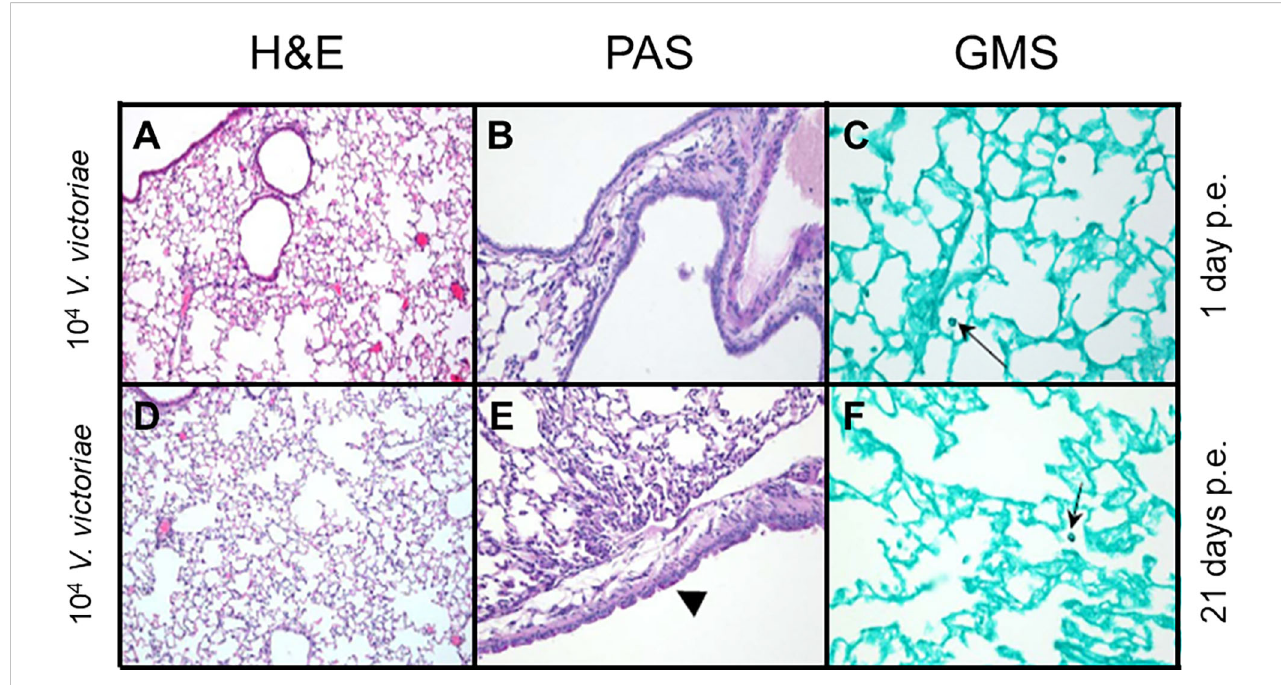
FIGURE 3 In fl ammation, airway changes, and yeast in fi ltration in lungs of mice after repeated exposure to 10 4 V. victoriae cells. Representative micrographs of stained sections of lung from mice 1 day (top) and 21 days (bottom) following repeated exposure 10 4 V. victoriae cells. Goblet cells are by arrowheads, and yeast cells by arrows. (A, D) H&E stain, 100x magni fi cation. (B, E) PAS-stain, 200x magni fi cation. (C, F) GMS-stain, 400x magni fi